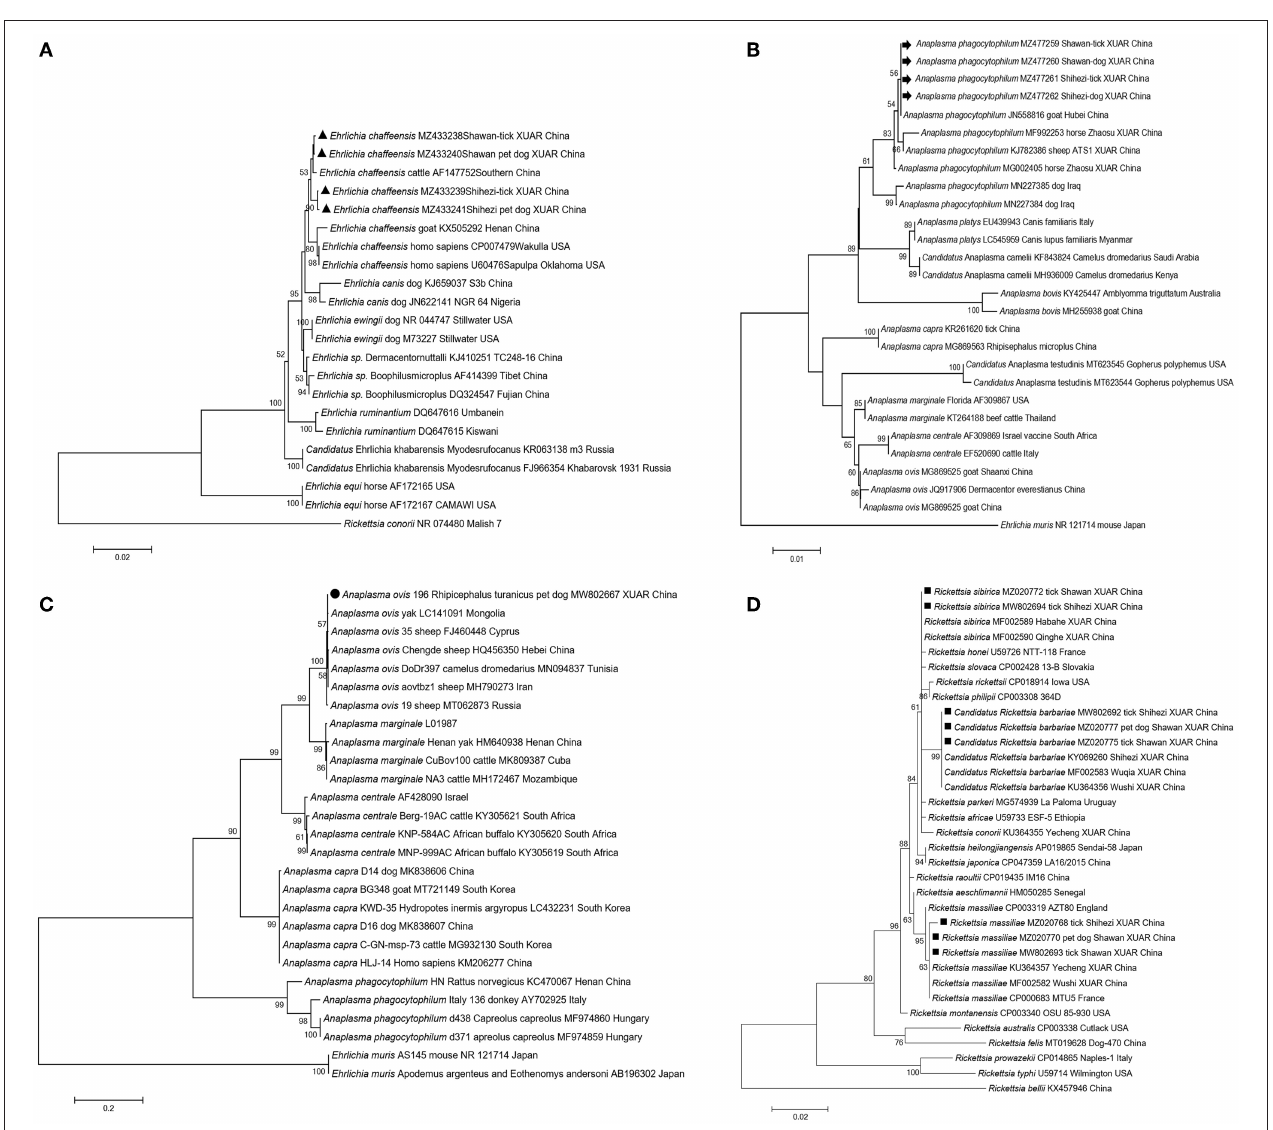
FIGURE 2 | Phylogenetic trees of tick-borne pathogenic bacteria detected from pet dogs and their associated ticks from Shihezi and Shawan, Junggar Basin, Xinjiang Uygur Autonomous Region, north-western China. The evolutionary history was inferred via the maximum-likelihood method (bootstrap replicates: 1,000) using MEGA X. New sequences obtained in this study are indicated in black triangles for Ehrlichia chaffeensis , black arrows for Anaplasma phagocytophilum , black circle for Anaplasma ovis , black squares for three Rickettsia species ( Rickettsia massiliae , Rickettsia sibirica , and Candidatus R. barbariae) based on gltA gene respectively. (A) Ehrlichia chaffeensis based on 16S rRNA gene; (B) Anaplasma phagocytophilum based on 16S rRNA gene; (C) Anaplasma ovis based on msp4 gene; (D) Rickettsia massiliae , Rickettsia sibirica , and Candidatus R. barbariae based on gltA gene.